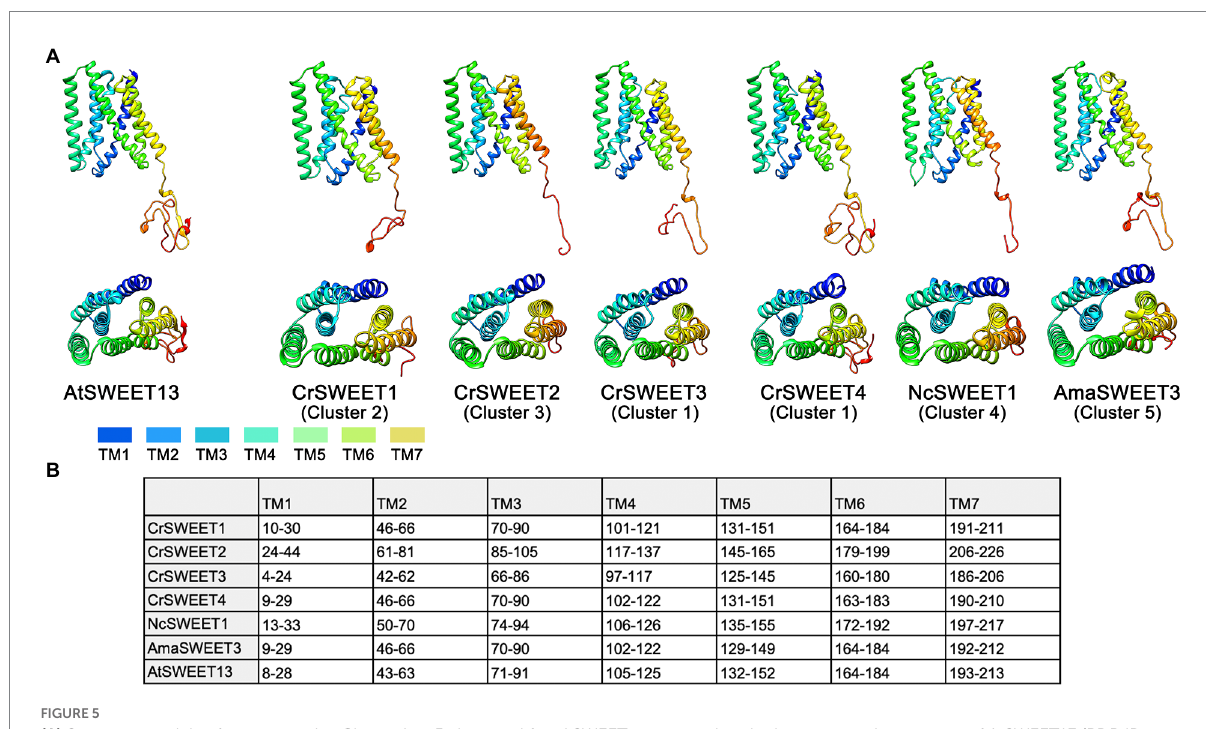
FIGURE 5 (A) Structure models of representative Cluster 1 to 5 algae and fungi SWEETs compared to the known protein structure of AtSWEET13 (PDB ID: 5XPD) that was used as the template for modelling. Ribbon structures of Cluster 1 (CrSWEET3 and CrSWEET4), Cluster 2 (CrSWEET1), Cluster 3 (CrSWEET2), Cluster 4 (NcSWEET1), Cluster 5 (AmaSWEET3) and template (AtSWEET13) SWEET proteins viewed from within the membrane (top image) and a top-down view from the extrafacial side (bottom image). TM helices are denoted by different colours. (B) Predicted location determined by TOPCONS for the seven TM helices of each SWEET protein sequence. Numbers refer to amino acid residues.